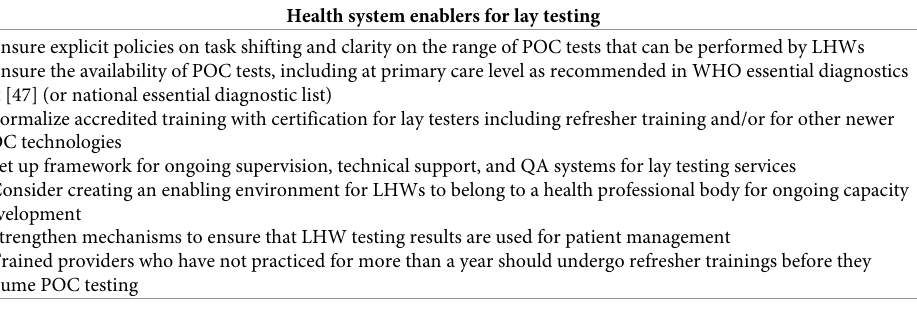
Table 2. Health system enablers for implementing lay